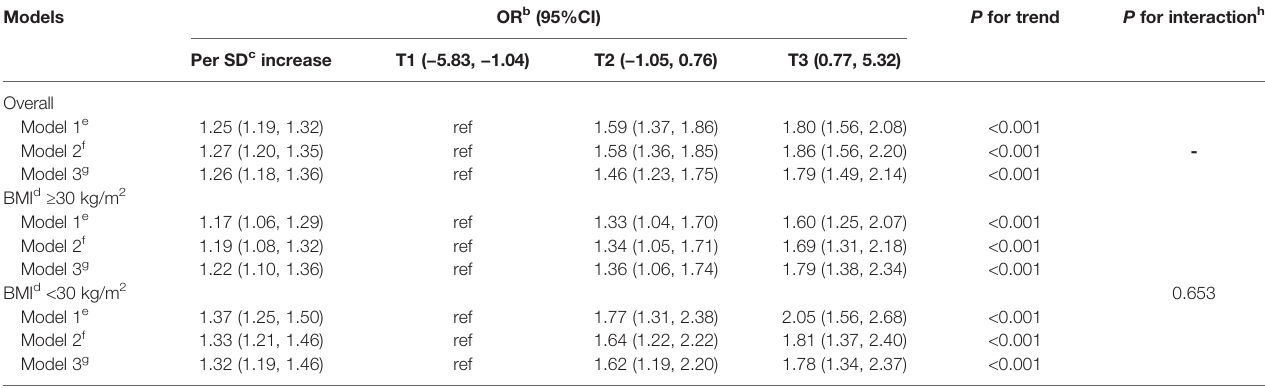
TABLE 4 | Multivariable-adjusted odds ratios (95%CIs) a of IR according to the tertiles of dietary in fl ammatory index (National Health and Nutrition Examination Survey 2007 – 2016). Models